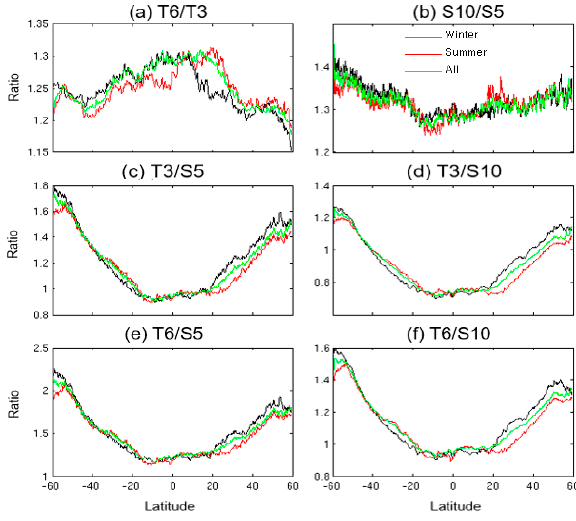
Figure 6. Similar to Figure 4, but over ocean.